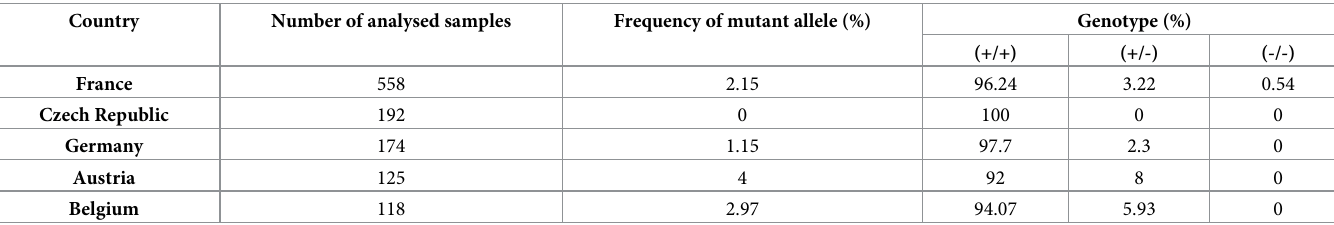
Table 7. Comparison of genotype and mutant allele frequencies in the top five countries for PRA-PRCD disease.